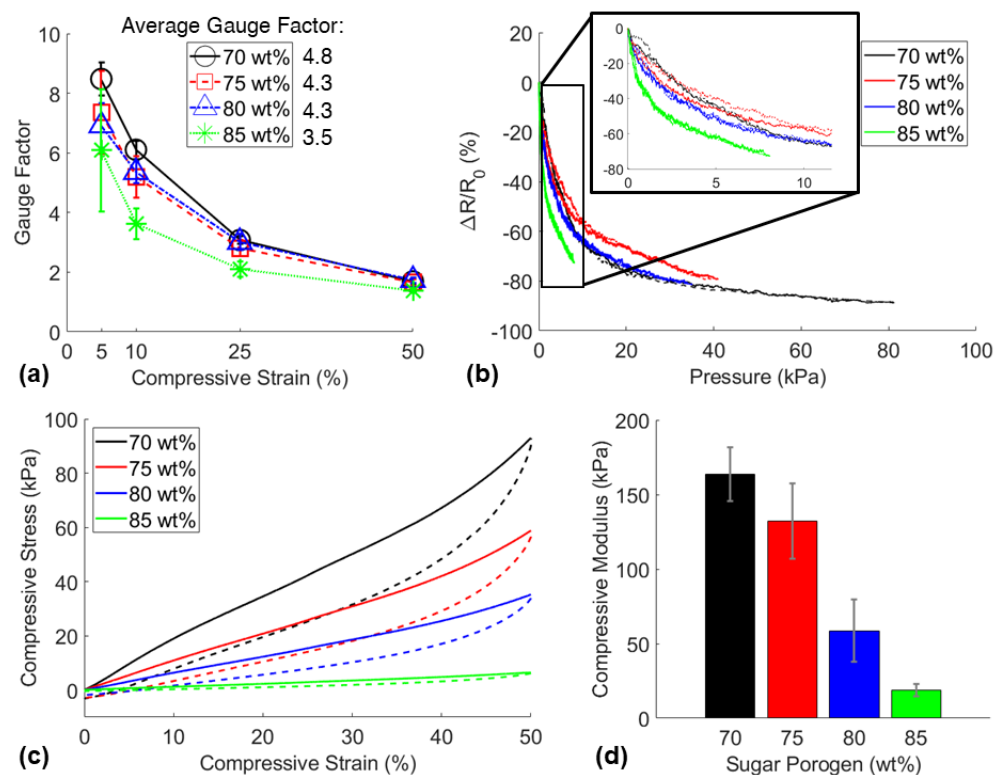
Figure 7. ( a ) Piezoresistive sensitivity comparison of sponges fabricated with various sugar porogen loadings and 3 wt% CNT loading, ( b ) representative relative resistance change signals of each sensor due to pressure applied during a 50% strain cycle, ( c ) stress-strain curves of sensors up to 50% compression, and ( d ) compressive modulus of the sensors.